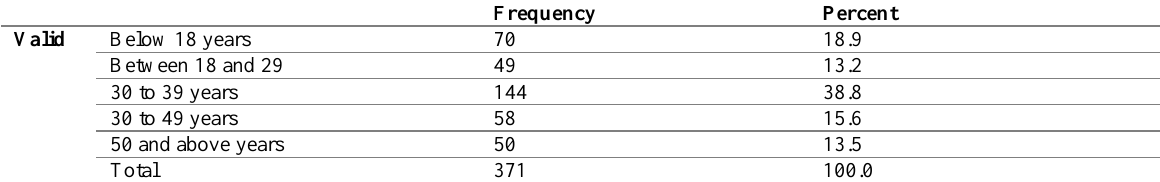
Table 3: Age of the Respondents